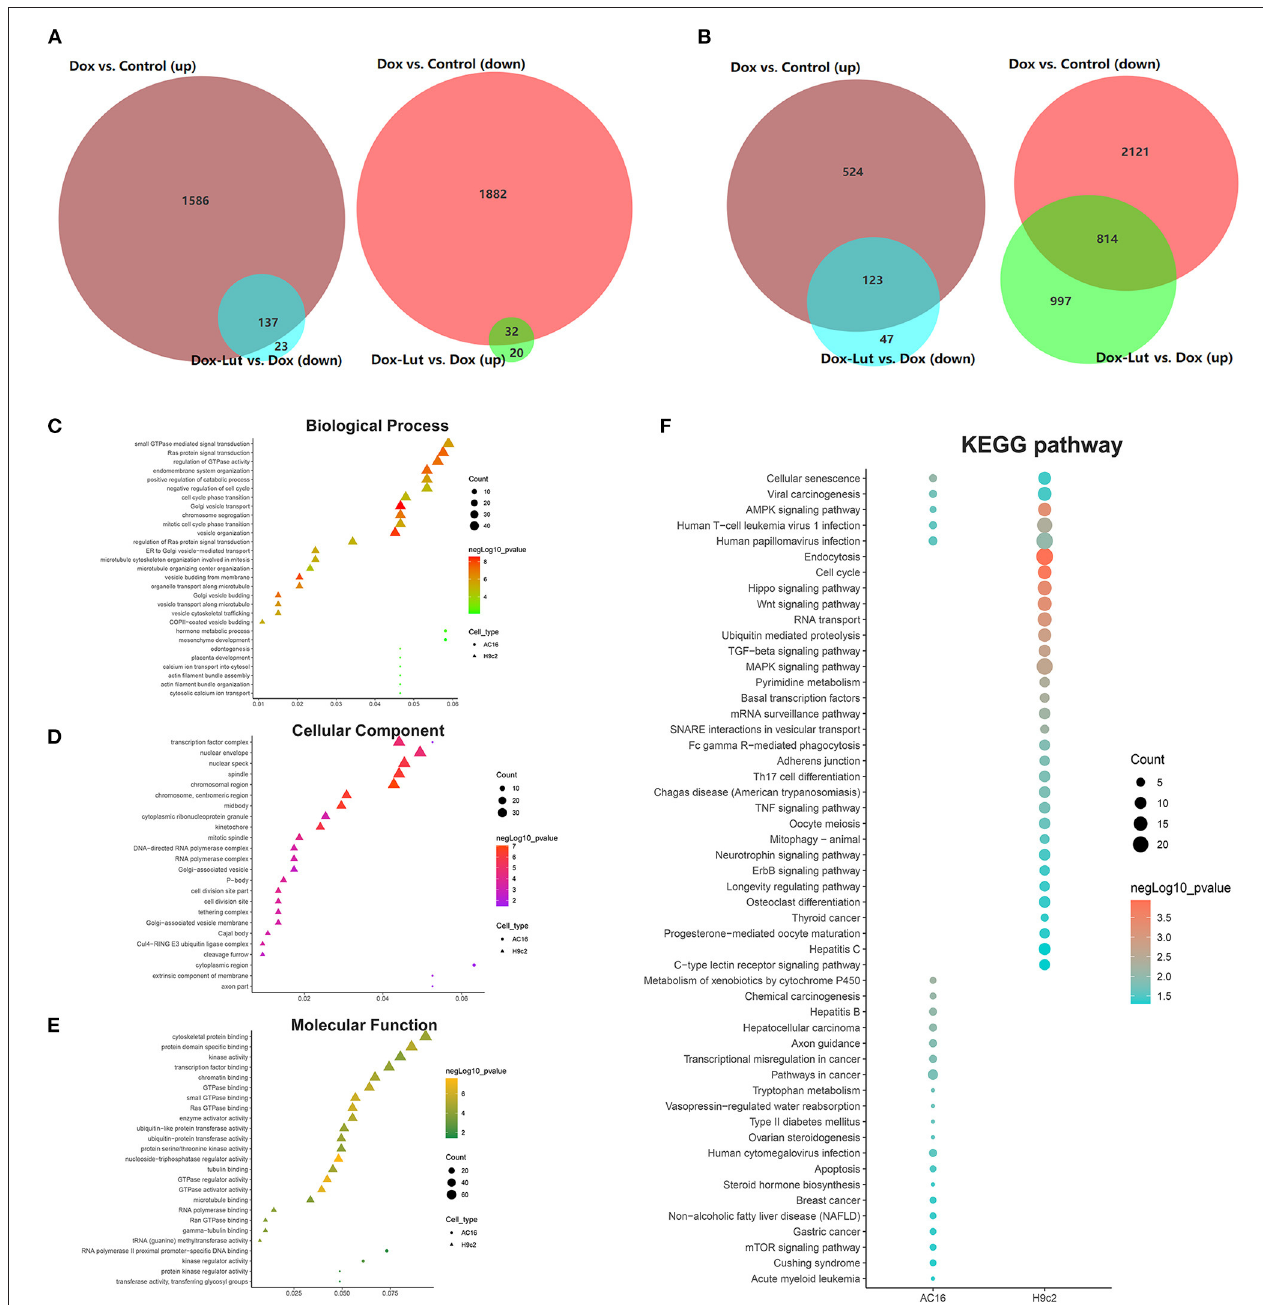
FIGURE 7 | GO and KEGG analysis of DEGs in the Dox–Lut group compared with Dox group. (A) Venn diagram. The intersection in the figure is the gene with the opposite differential expression, which is defined as the gene affected by Lut in AC16 and (B) H9c2 cells. (C) Biological processes, (D) cellular component, (E) molecular function, and (F) KEGG pathways involved in resveratrol-affected genes.